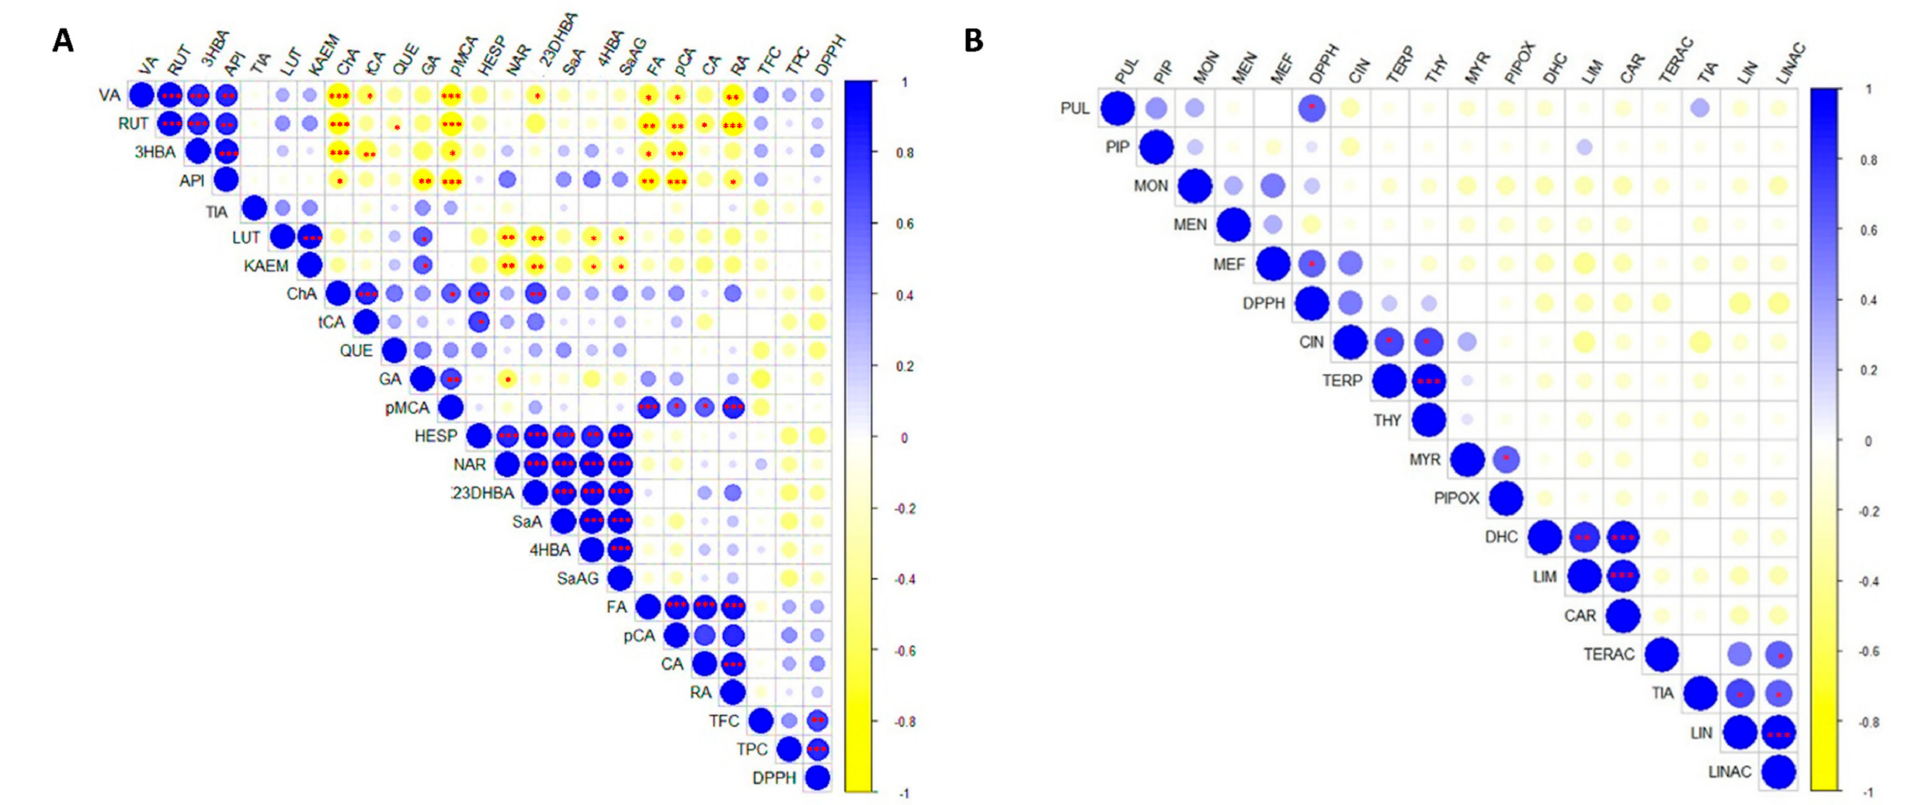
Figure 5. ( A ) Correlation matrix between phenolics, total flavonoids (TFC), total phenolics (TPC), and antioxidant (DPPH) and tyrosinase (TIA) activity in Mentha species. ( B ) Correlation matrix between terpenoids and DPPH and TIA in Mentha species. Red asterisks indicate the significance of the correlation (* p < 0.05; ** p < 0.01; *** p < 0.001). VA: vanillic acid; RUT: